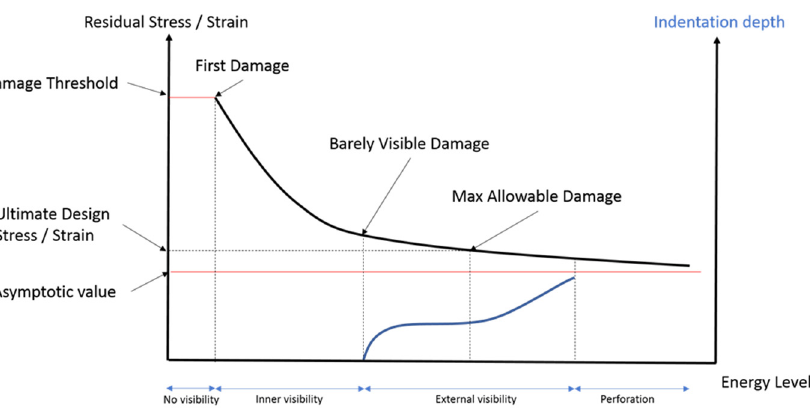
Figure 3. Schematic representation of residual strain versus energy level and derived design constraints.